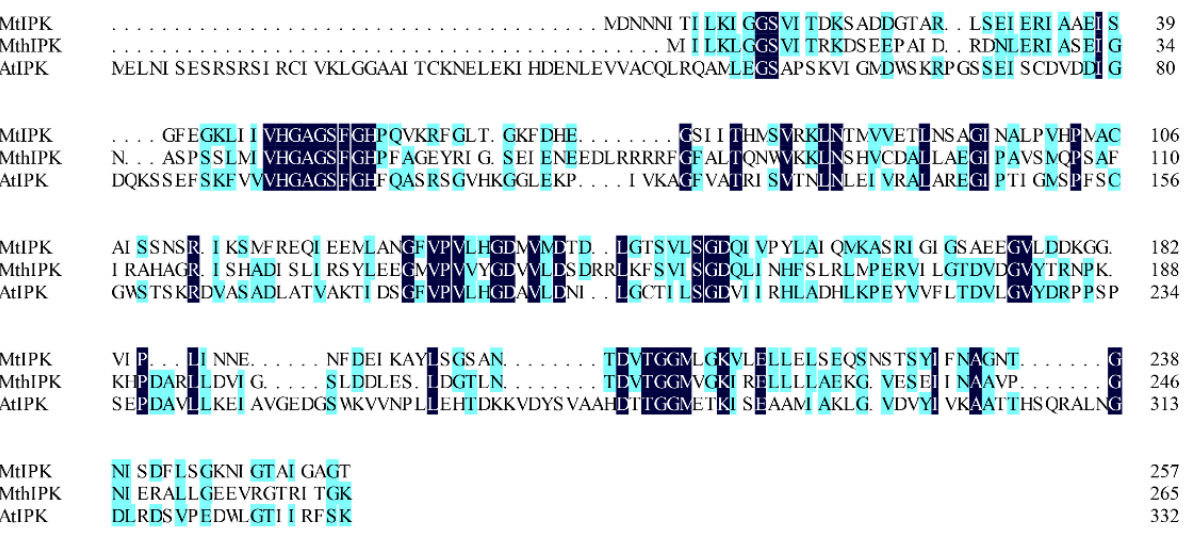
Figure 6. Alignment of isopentenyl phosphate kinases. MtIPK: Methanolobus tindarius isopentenyl phosphate kinase, MthIPK: Methanothermobacter thermautotrophicus str. Delta H isopentenyl phos- phate kinase, AtIPK: Arabidopsis thaliana isopentenyl phosphate kinase.